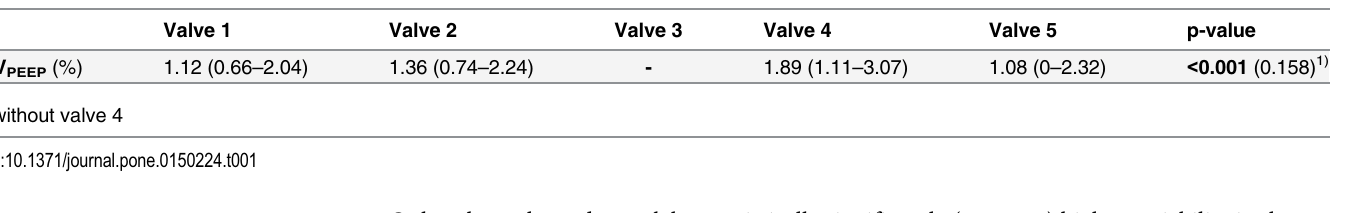
Table 1. Coefficient of